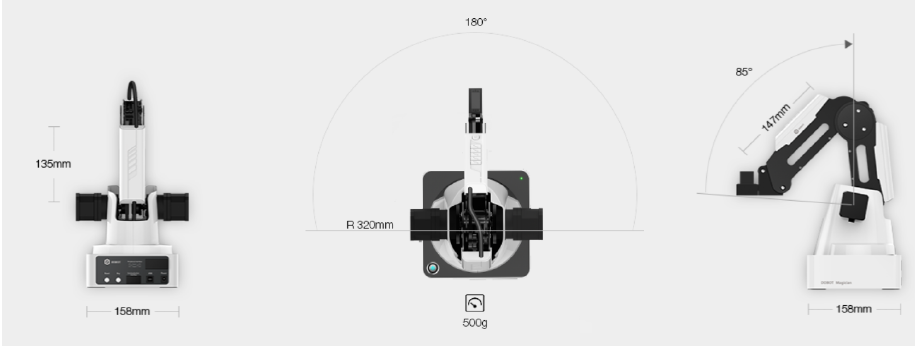
Figure 3. Robotic arm specifications.